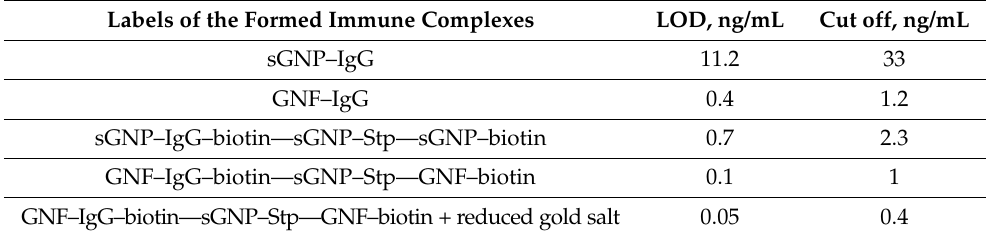
Table 2. Integrated characterization of the developed ICA of FABP by their LOD and cut off values. Labels of the Formed Immune Complexes